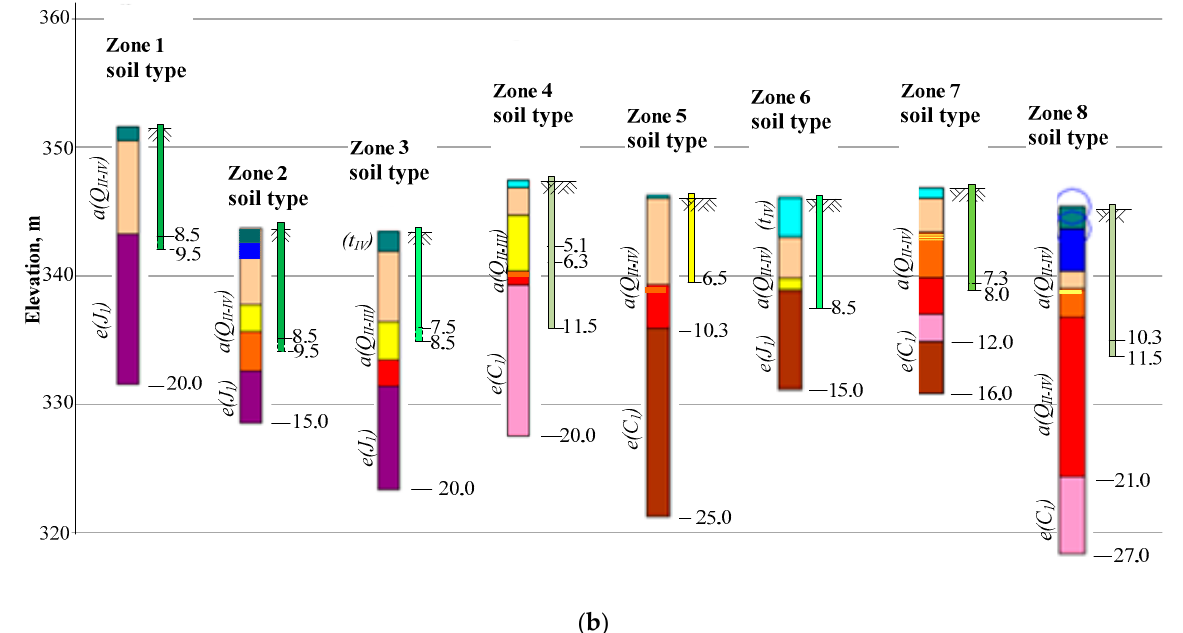
Figure 8. Zoning map for optimization of pile lengths ( a ) and representative borehole profiles ( b ) for each city zone.